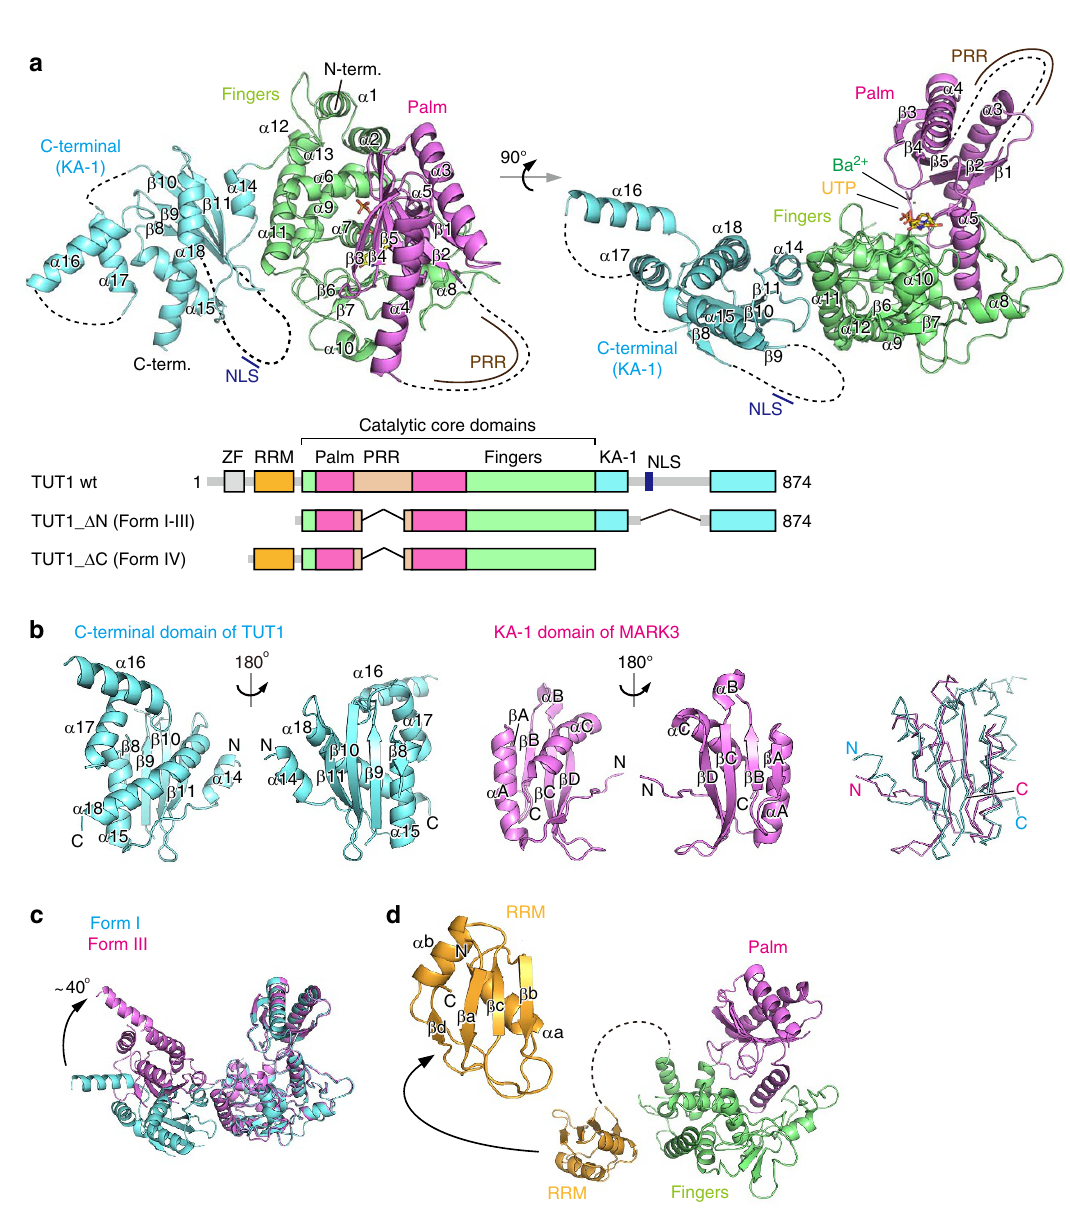
Figure 1 | Overall structure of human TUT1. ( a ) Overall structure of form-I TUT1_ D N. The palm, fingers and C-terminal (KA-1) domains are coloured magenta, green and cyan, respectively. Dashed lines are the proline-rich and nuclear localization signal regions removed for crystallization, and the disordered regions. UTP is depicted by a yellow stick model. The barium ion (Ba 2 þ ) is depicted by a dark green sphere. Schematic diagrams of human full- length TUT1, TUT1_ D N and TUT1_ D C, which were crystallized. ZF, zinc finger; RRM, RNA recognition motif; PRR, proline-rich region; NLS, nuclear localization signal; KA-1, kinase associated-1. ( b ) Comparison of the structures of the C-terminal domain of TUT1 (left, cyan) and the KA-1 domain of MARK-3 (ref. 26) (middle, magenta), and superimposition of the two structures in ribbon models. ( c ) Superimposition of the form-I (cyan) and -III (magenta) structures of TUT1_ D N. The form-III structure adopts a closed form relative to the form-I structure, with respect to the catalytic core domains. ( d ) Overall structure of TUT1_ D C (form-IV). The RRM is coloured orange.